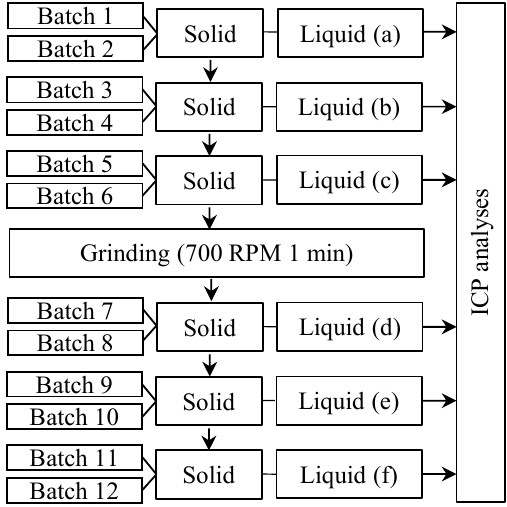
Figure 2. Batches dissolution experiments.